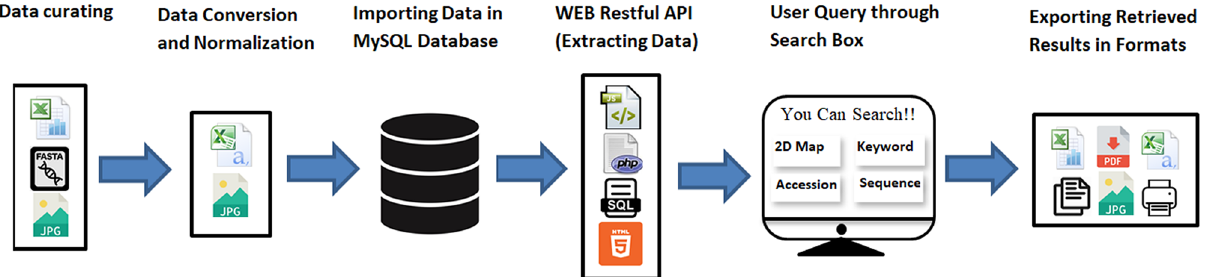
Figure 1. Flowchart depicting the design of PlantMWpIDB of plant